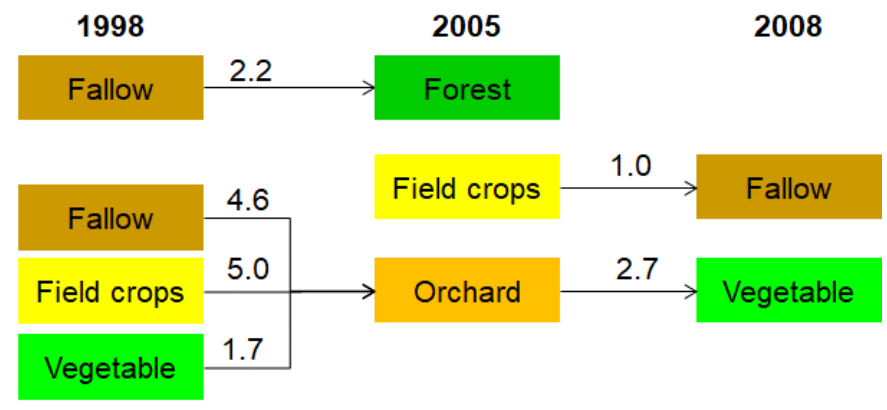
Figure 4. LUC trajectories (>5 ha) detected through land-use change intensity analysis; values refer to net area change (%) of total watershed area (10.6 km²) in 1998, 2005 and 2008.